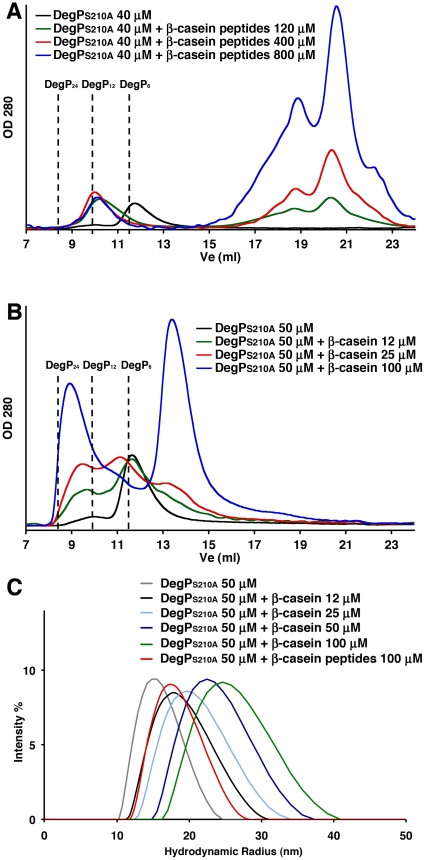
Oligomeric state of DegPS210A at various substrate concentrations.Elution profiles of DegPS210A in the presence of various concentrations of β-casein peptides (A) or full-length β-casein (B). The expected elution volumes (Ve) for DegP6 (11.5 ml), DegP12 (9.9 ml) and DegP24 (8.4 ml) are indicated by the dashed lines in the plot. (C) Dynamic light scattering analysis of DegPS210A in the presence of variable concentrations of full-length β-casein or β-casein peptides. The graph shows the distribution of hydrodynamic radius of particles for various mixtures of DegPS210A and full-length β-casein or DegPS210A and β-casein peptides.